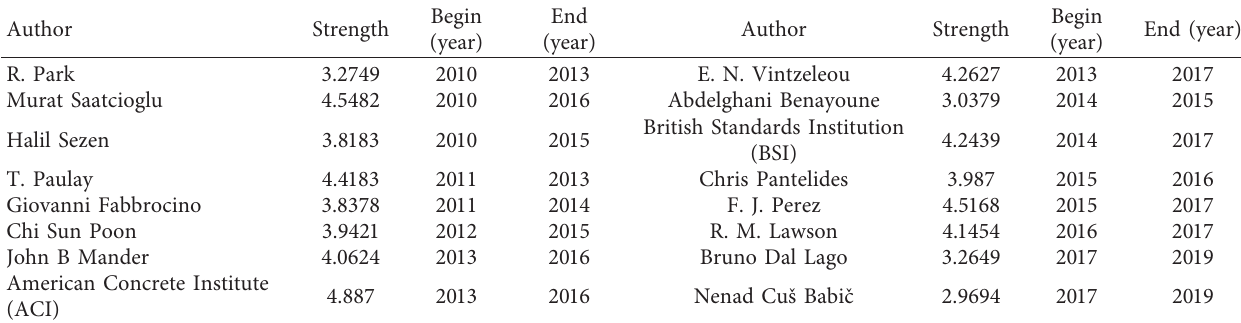
Table 8: Top 16 authors’ co-citation with the strongest citation bursts in each corresponding